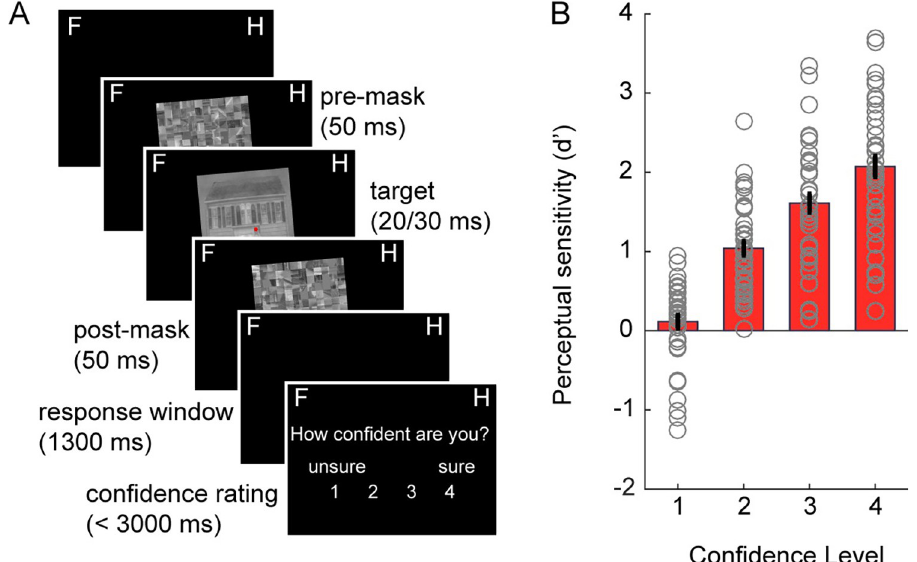
Fig 1. Task and behavior. ( A ) Each trial started with a central red fixation dot after which a forward mask was shown, followed by an image of a face or a house and a backward mask. Images were either tilted to the right or to the left (task-irrelevant feature, 5˚ or 355˚ angle). Note that in the example trial, only a left-tilted house image is shown. Participants reported whether they perceived a house or a face and indicated their confidence in this decision. ( B ) Perceptual sensitivity (d’) as a function of decision confidence. The underlying data and scripts supporting this figure can be found on FigShare (https://doi.org/10.21942/uva.c.6265233.v1).